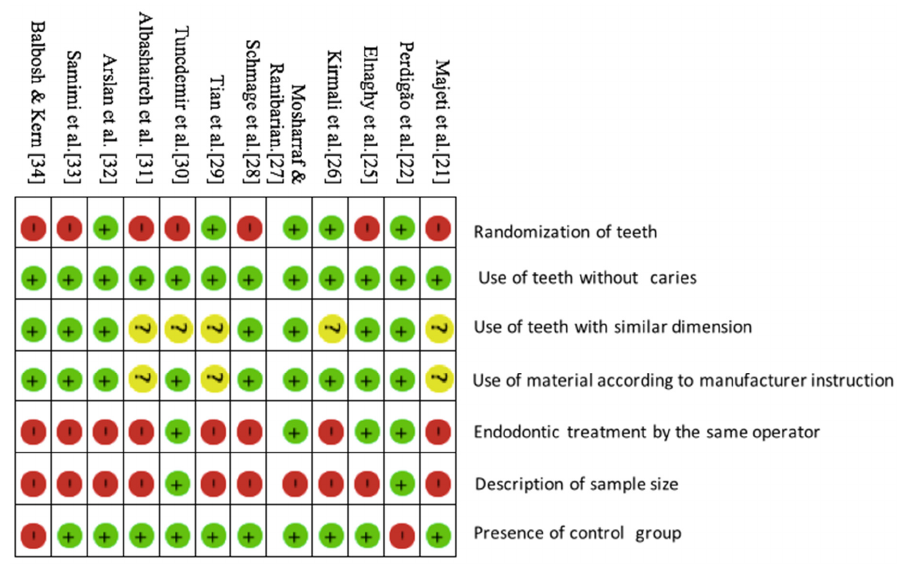
Figure 2. Risk of